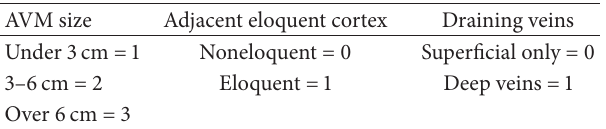
Table 1: Spetzler-Martin AVM Grading Scale. The score is calcu- lated by summing the points for each